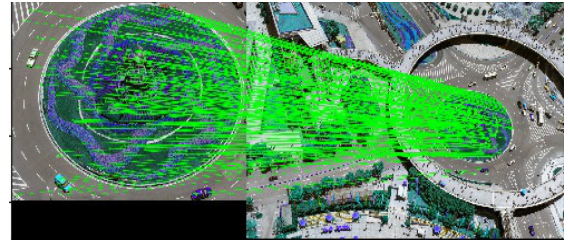
Figure 5. Image Feature Matching